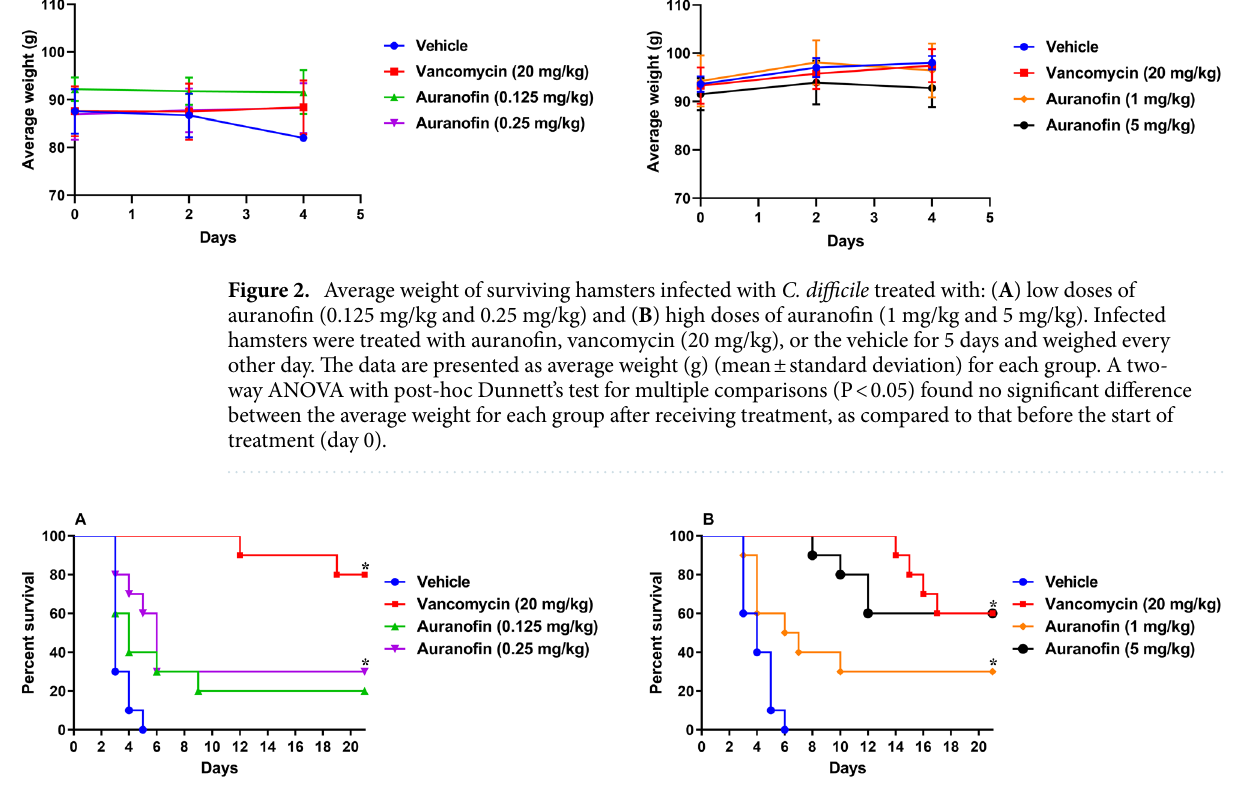
Figure 3. Efficacy of auranofin against CDI recurrence in hamsters: ( A ) low doses (0.125 mg/kg and 0.25 mg/ kg) and ( B ) high doses (1 mg/kg and 5 mg/kg). Hamsters were treated with auranofin, vancomycin (20 mg/ kg), or the vehicle after infection with C. difficile UNT103-1. Treatments were discontinued after 5 days. Kaplan–Meier survival curves were analyzed using a log-rank (Mantel–Cox) and Gehan–Breslow–Wilcoxon tests (P < 0.05). An asterisk (*) denotes a statistically significant difference between hamsters treated with either auranofin or vancomycin in comparison to the vehicle-treated